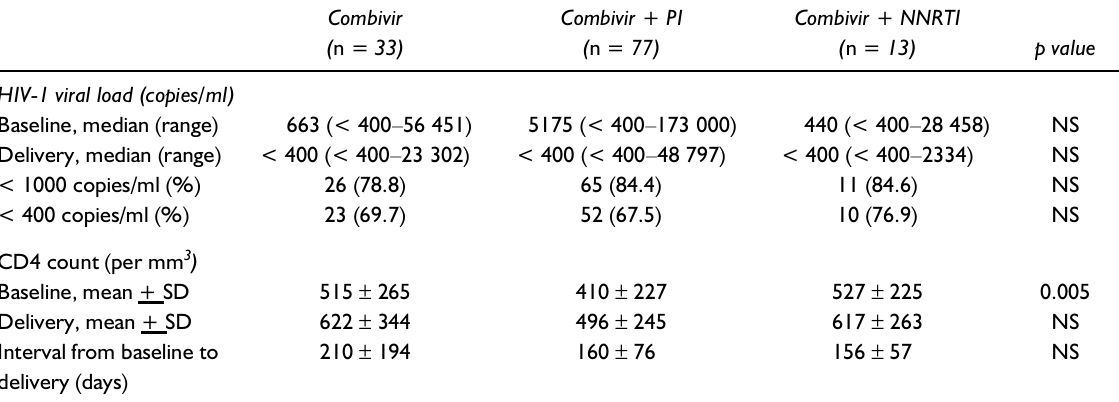
Table 1 Viral load at baseline and delivery